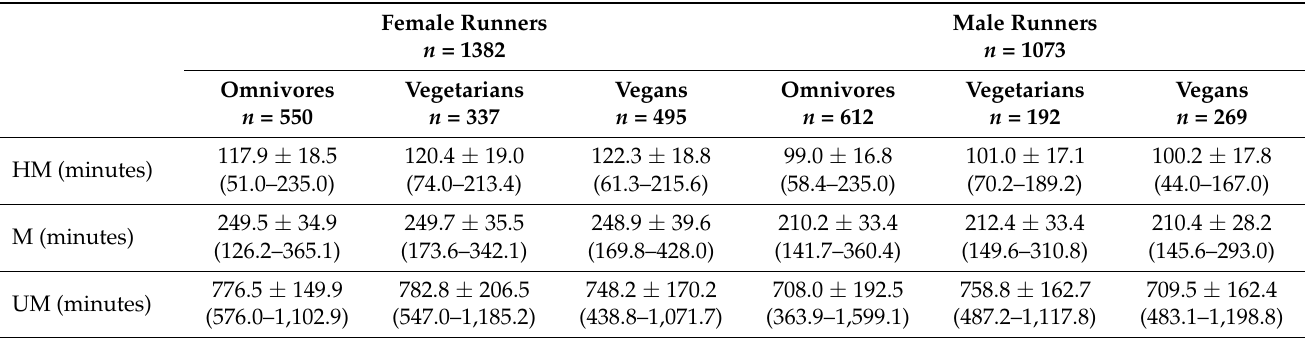
Table 2. Best time as individual records for completion of half-marathon, marathon, and ultra- marathon events in male and female runners based on dietary subgroups.